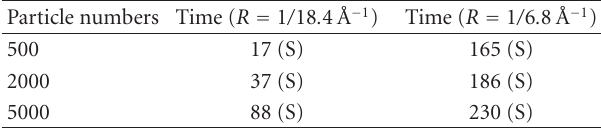
Table 5: The algorithm time of the OSAF method for reconstruct- ing DegP 24 model at low and high resolution (S means